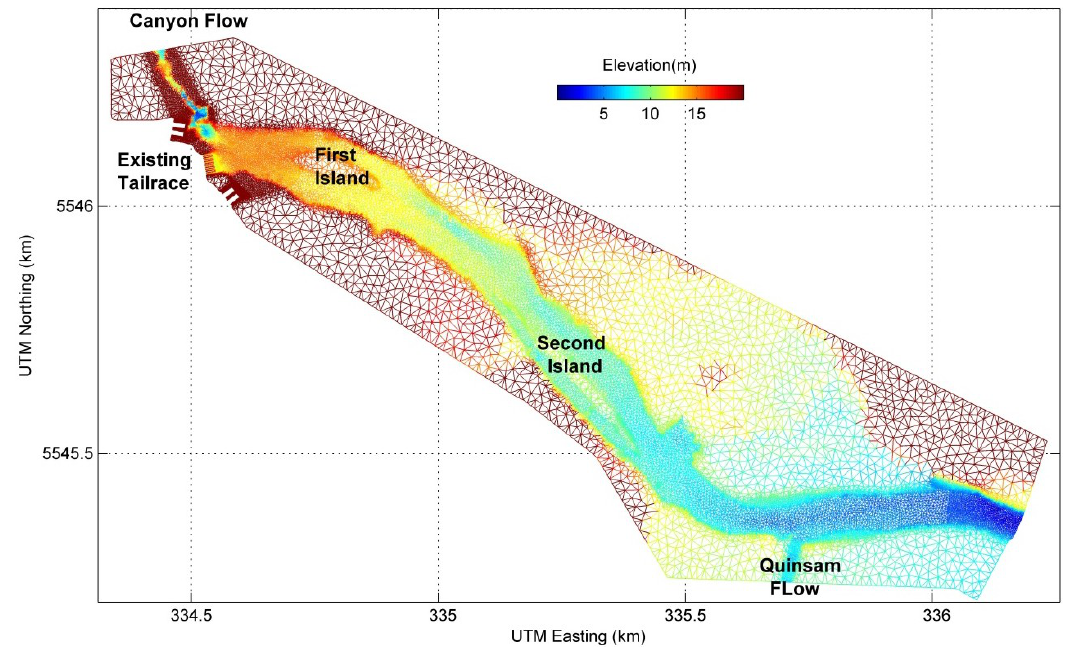
Figure 2. A map showing the model mesh and bottom elevation of the Lower Campbell